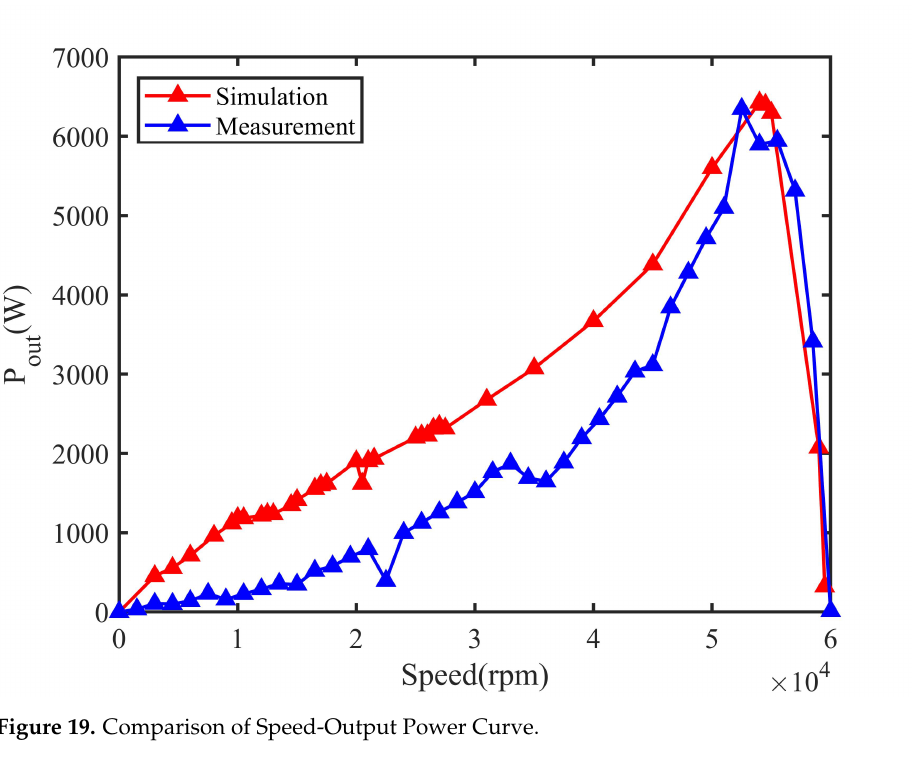
Figure 19. Comparison of Speed-Output Power Curve.